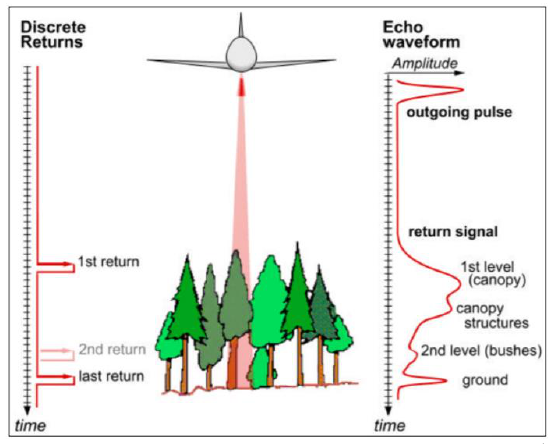
Figure 1. Schema of discrete and full-waveform lidar (from Daly et al.,